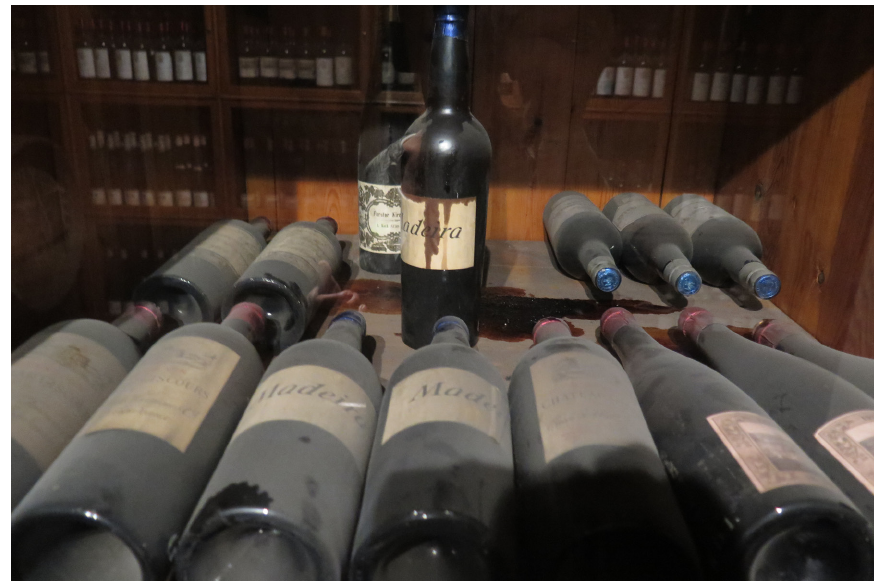
Figure 1: The Hallwyl cellar displays hundreds of opened and now emptied wine bottles. (Photo: Lizette